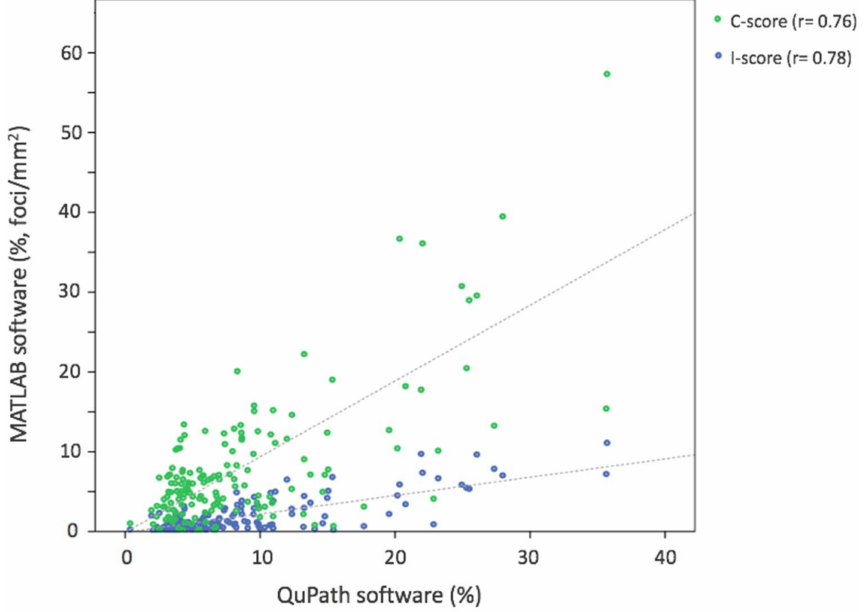
Figure A3. Scatterplots of QuPath data and the parameters obtained with our MATLAB software: clusters proportion (C-score in green dots) and inflammatory proportionate area (I-score in blue